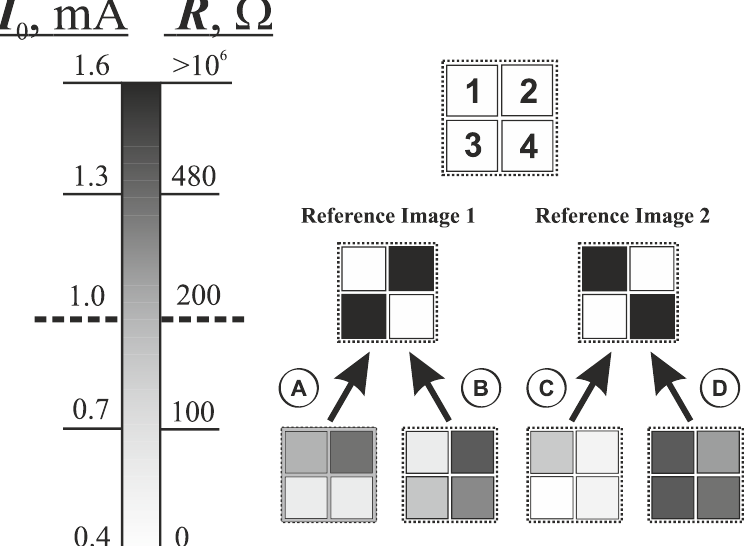
Figure 8. The gray gradation of patterns for the initial supply currents I 0 (impulsive HN1, IHN1) and resistances R (IHN2) (left). The numbering of neurons in the network, symmetrical reference images and input patterns (A–D) (right). (A) and (B) are recognized as Reference Image 1, (C) and (D) are recognized as Reference Image